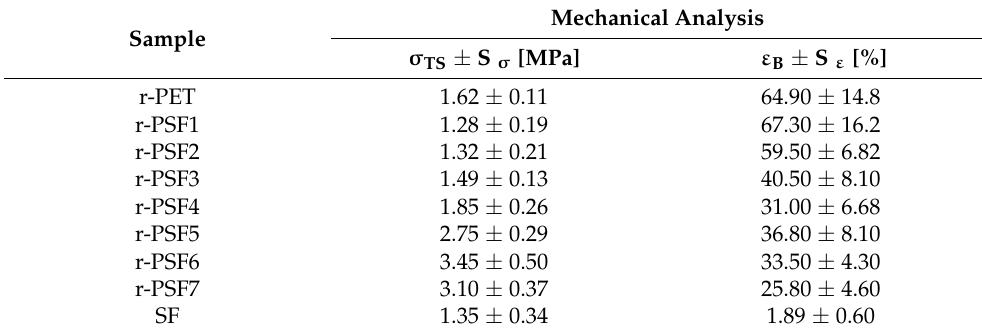
Table 3. Summarized results of mechanical